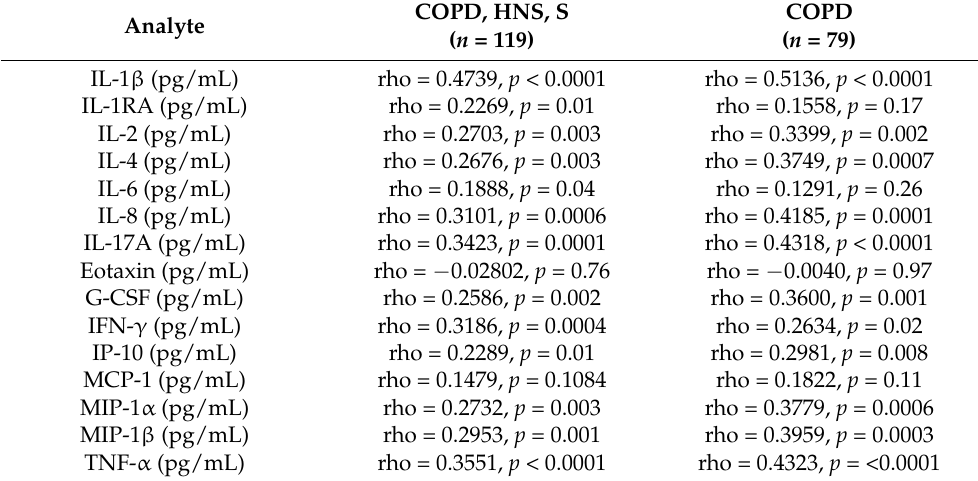
Table 5. Cohort B: Sputum Neutrophil Percentage and Supernatant Cytokine